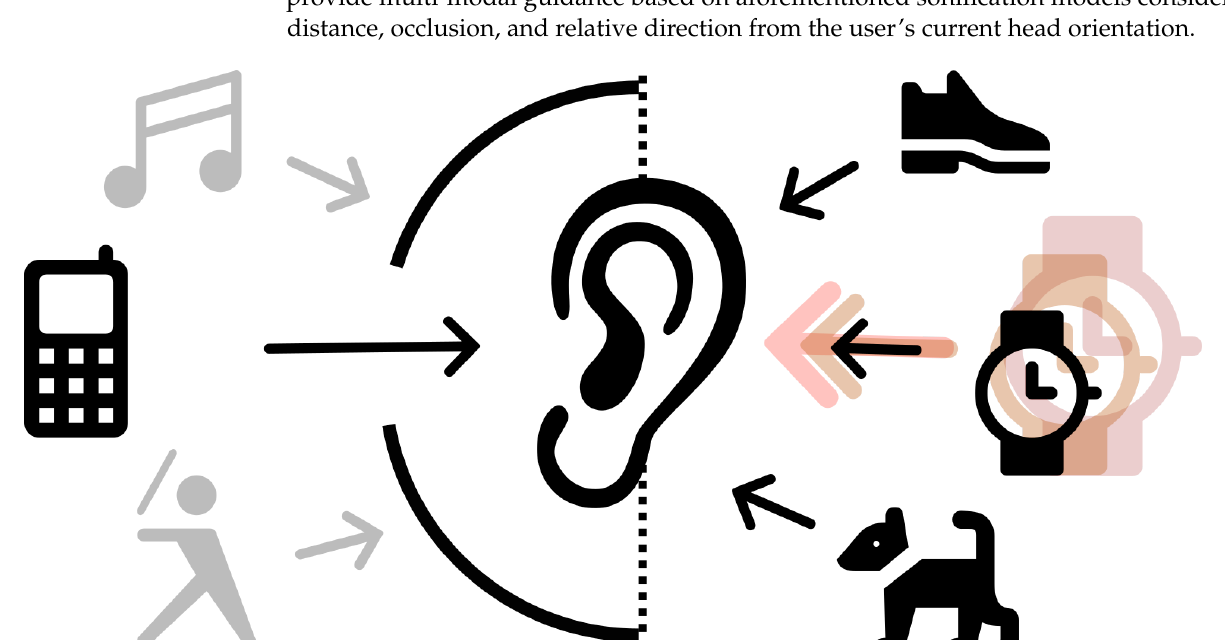
Figure 4. Personal auditory peripheral displays may provide information in a subtle manner by deliberately allowing certain sounds to pass-through a noise cancellation (left) or by accentuating sounds in the soundscape